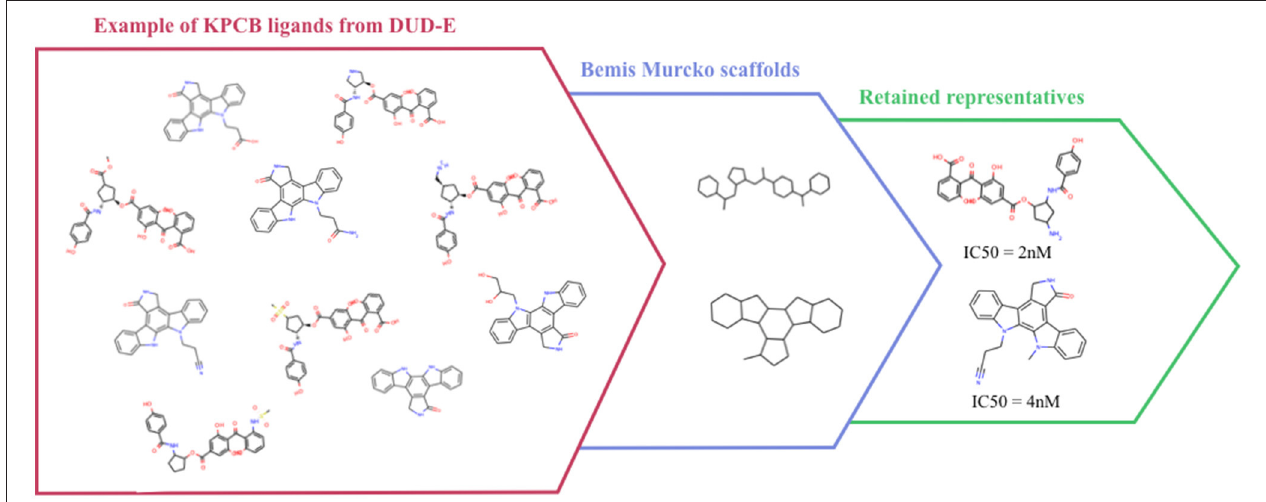
FIGURE 2 | Example of Bemis-Murcko atomic frameworks clustering of Protein kinase C beta type (KPCB) ligands from the